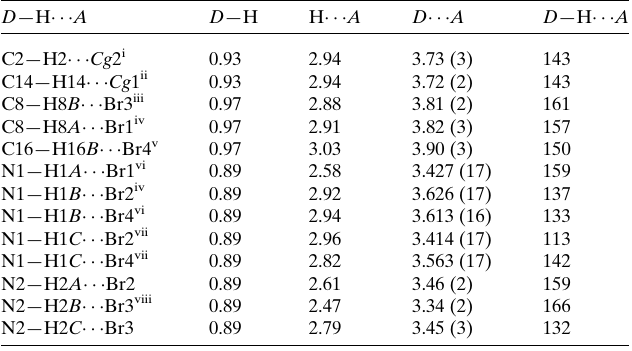
Table 1 Hydrogen-bond geometry (A˚ , (cid:5) ).